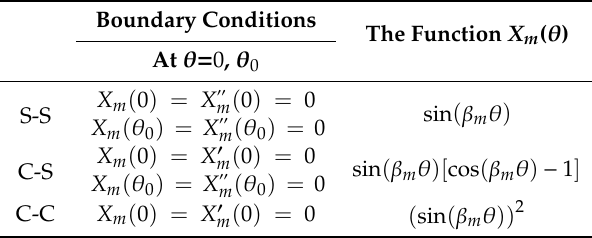
Table 1. Admissible function X m ( θ )